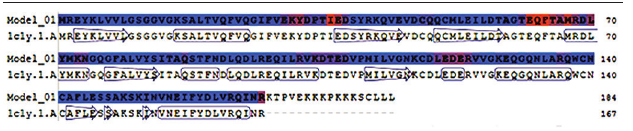
figurE 15 − RAS gene – model – template alignment